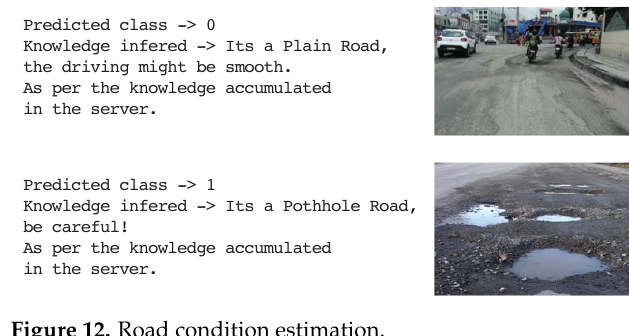
Figure 11. Estimation results by the TAKEN model with object and depth estimation in ( A ) and depth and sector estimation in ( B ).